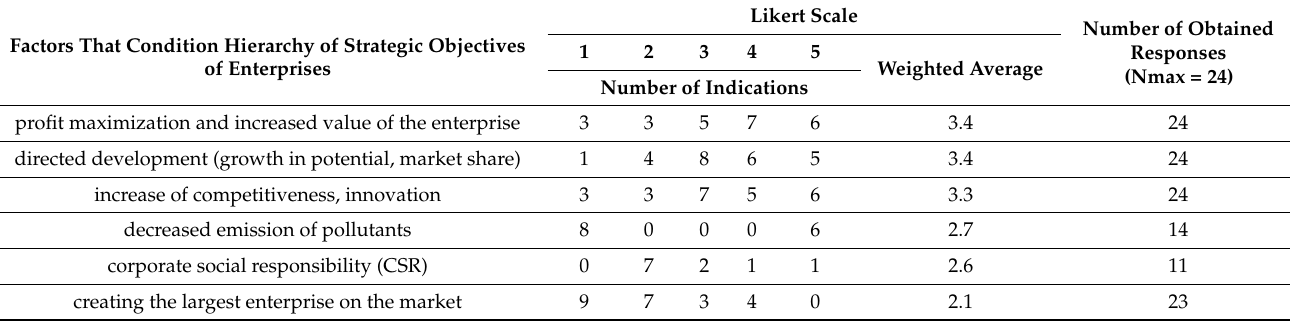
Table 3. Factors describing the hierarchy of objectives in the case of design and construction enterprises of photovoltaic farms—Likert scale